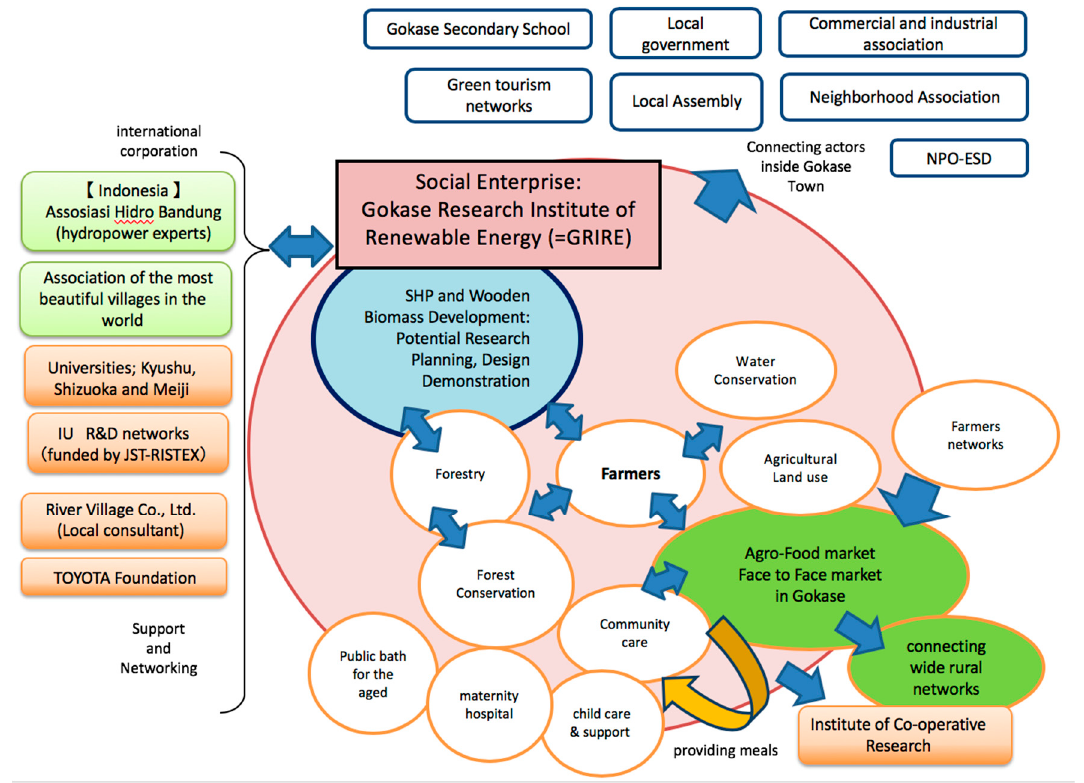
Figure 2. Network between GRIRE and other bodies for local renewable energy production.